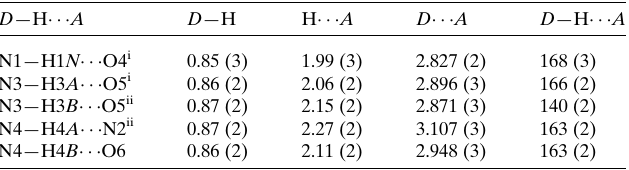
Table 1 Hydrogen-bond geometry (A˚ , (cid:4) ).